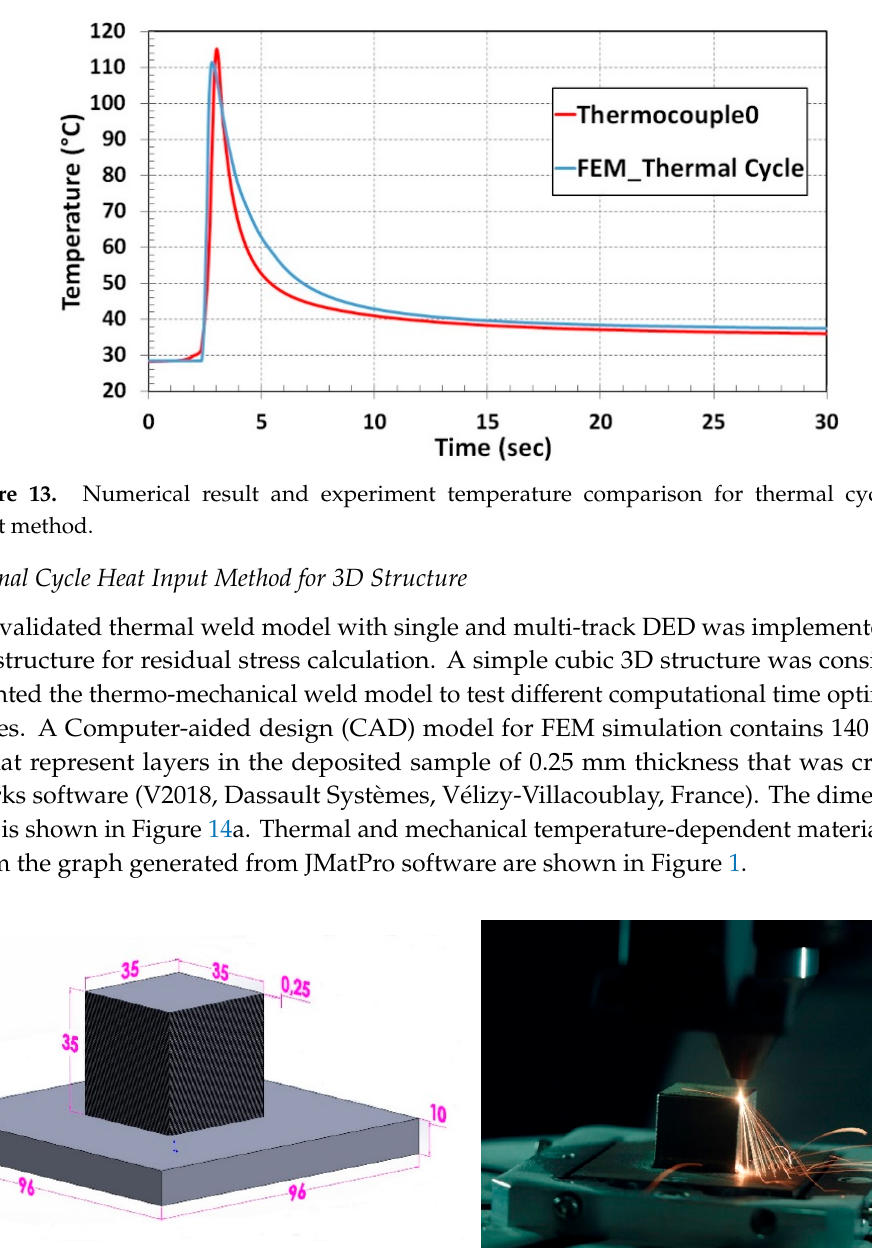
Figure 14. ( a ) A CAD model of the cubic structure with dimensions in millimeters; ( b ) 3D cubic structure deposition.